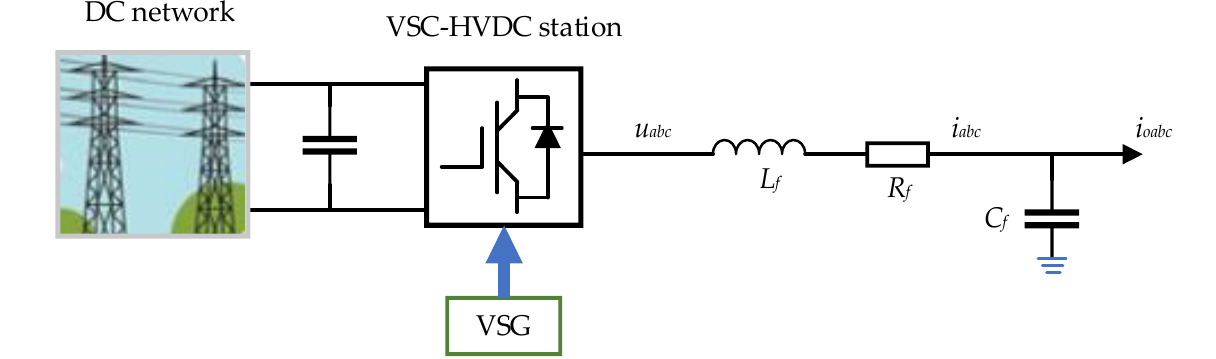
Figure 20. Schematic diagram of VSC-HVDC with VSG.